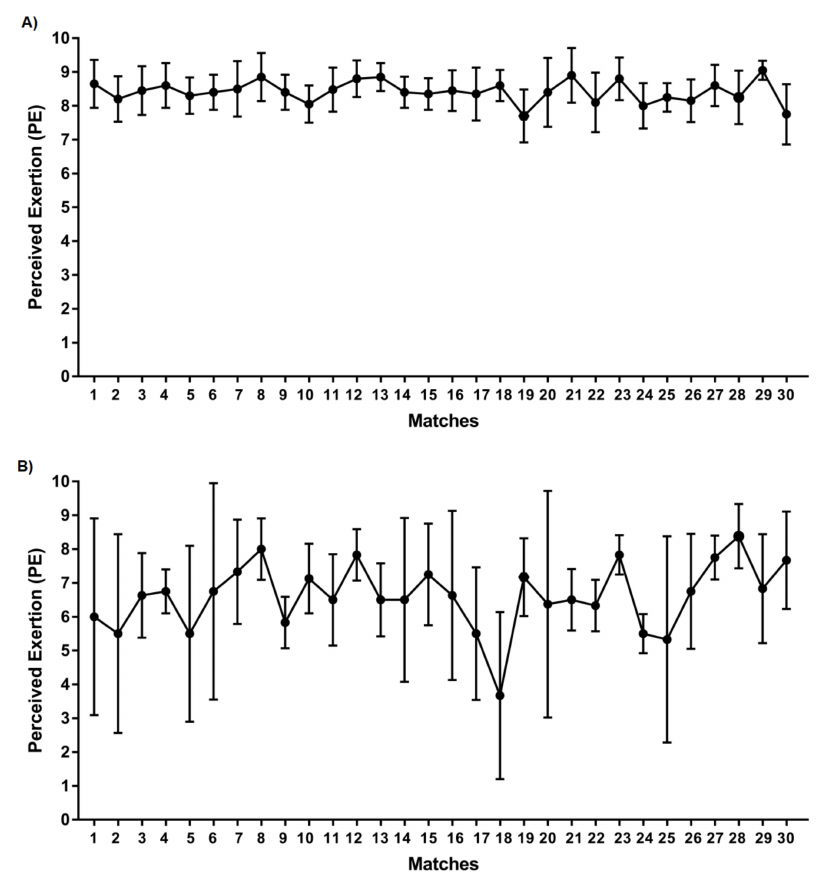
Figure 1. Perceived exertion (PE) declared by starters ( A ) and non-starters ( B ) during o ffi cial matches along the